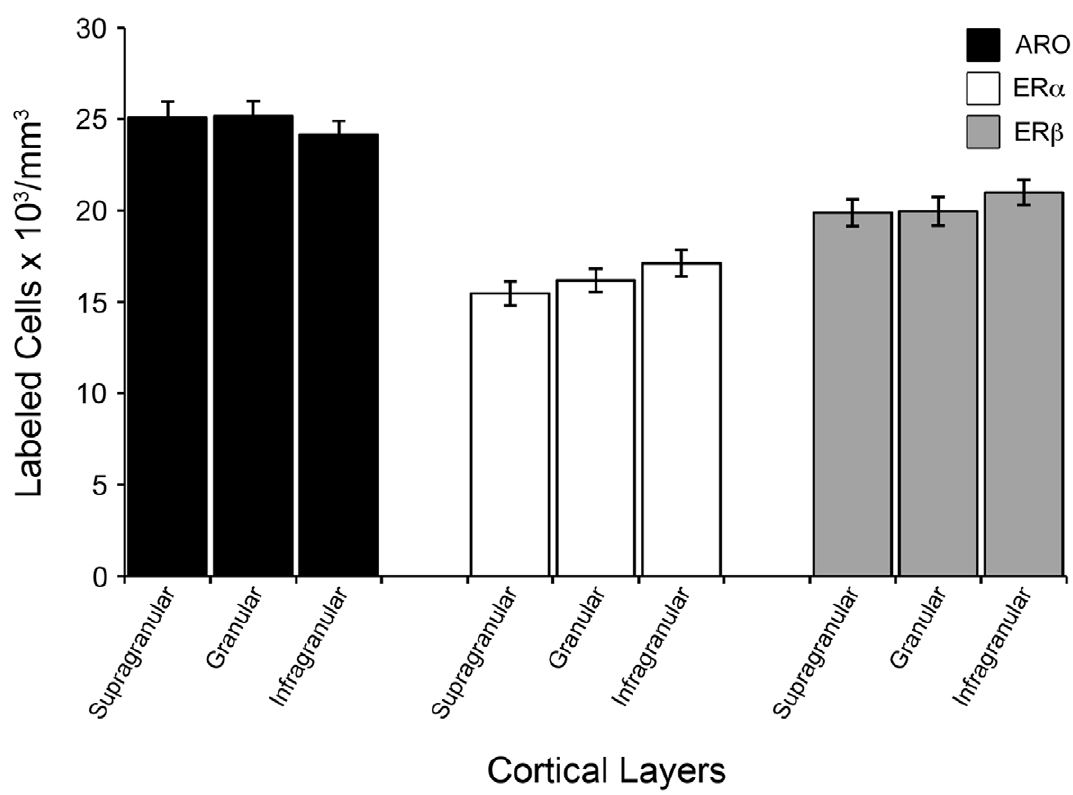
Figure 2. Large populations of neurons in the adult V1 putatively produce and are sensitive to estrogens. Shown are mean ( 6 S.E.) numerical densities obtained for supragranular, granular and infragranular layers, of V1 neurons that are positive for ARO-, ER a and ER b . Stringent unbiased stereological methods were used to obtain these values (see Methods). No statistically significant effects were detected across layers for each of the mRNAs studied.